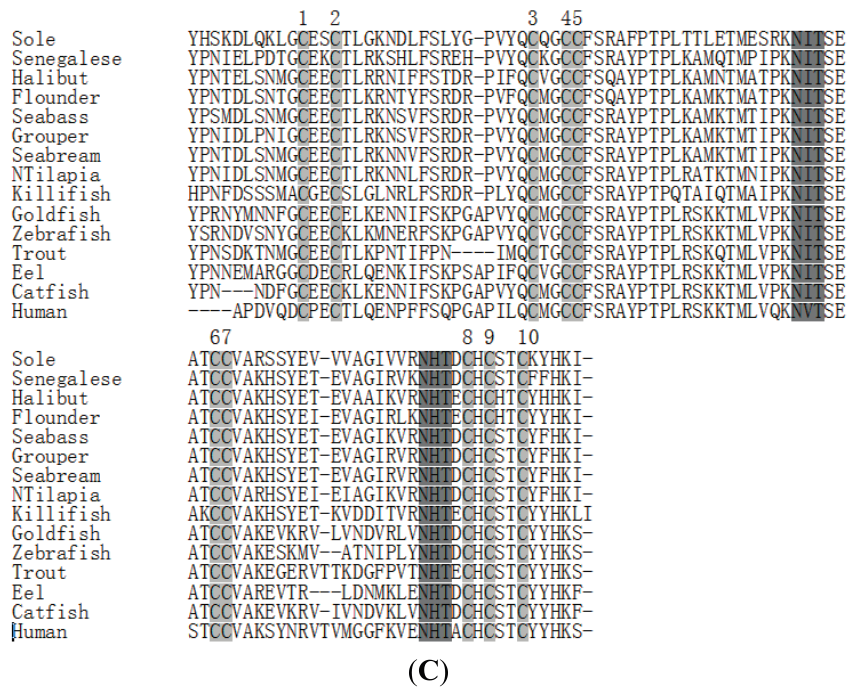
Figure 4. Alignment of amino acid sequences of C. semilaevis mature FSH β ( A ), LH β ( B ) and CG α ( C ) subunits with those of representative vertebrates. The cysteine residues are marked by gray shadow and numbered from the N terminus. The N-linked glycosylation sites are indicated by black shadow. Sole: Cynoglossus semilaevis , Senegalese: Solea senegalensis , Hippoglossus hippoglossus , Flounder: